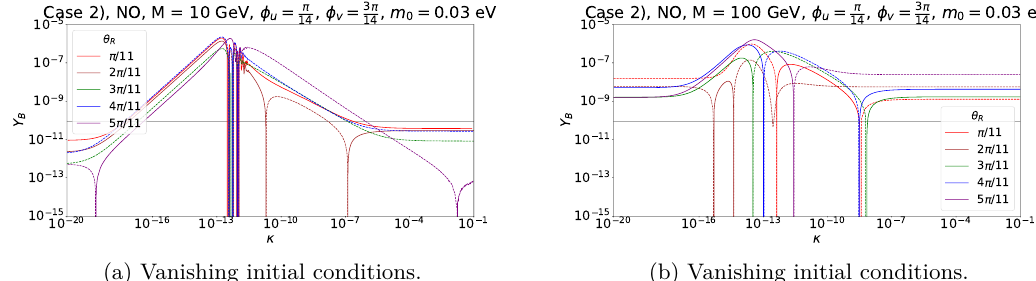
Figure 18 . Case 2) Y B as function of the splitting κ for different values of θ R and for M = 10 GeV (left plot) and M = 100 GeV (right plot). The group theory parameters n , u and v are taken to be n = 14 , u = 1 and v = 3 (equivalent to s = 1 and t = 1 ). Light neutrino masses follow NO and m has been set to 0 . 03 eV. Since both the splitting κ and m do not vanish, we can 0 0 study the interplay between different contributions to the BAU, associated with the three different CP-violating combinations C , C and C . For the rest of the choices see figure 16. LFV ,α LNV ,α DEG ,α